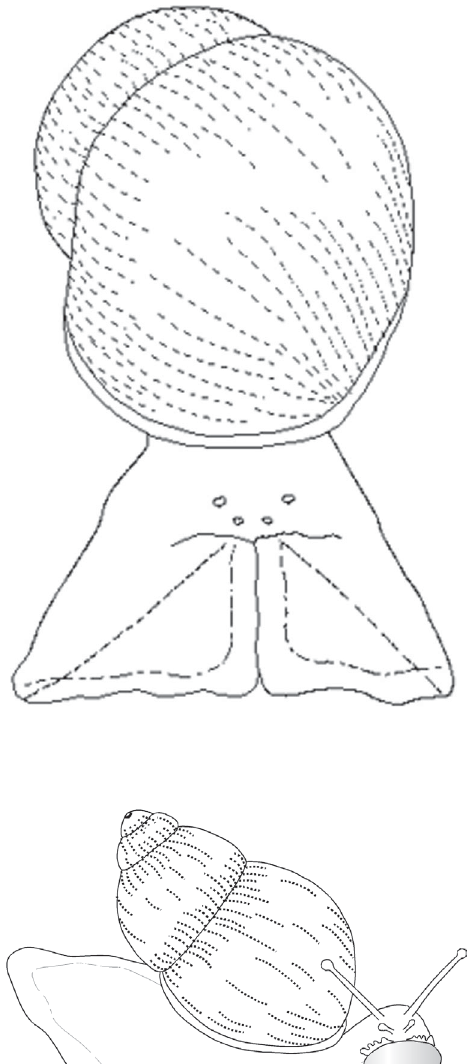
Figure 1. Schematic representa- tion of the snail Megalobulimus abbreviatus in the first phase of aversive behavior. Note the re- tracted oral tentacles and labial palps and the triangular aspect of the head-foot complex when the snail was placed on the hot plate.